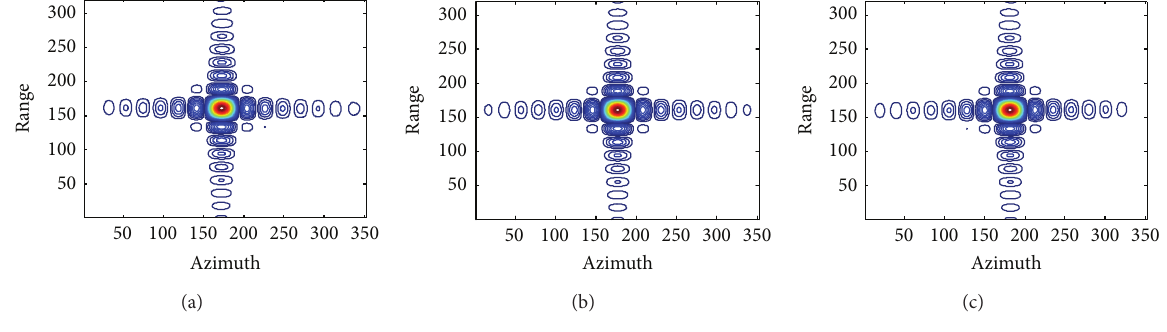
Figure 7: Contour plots of